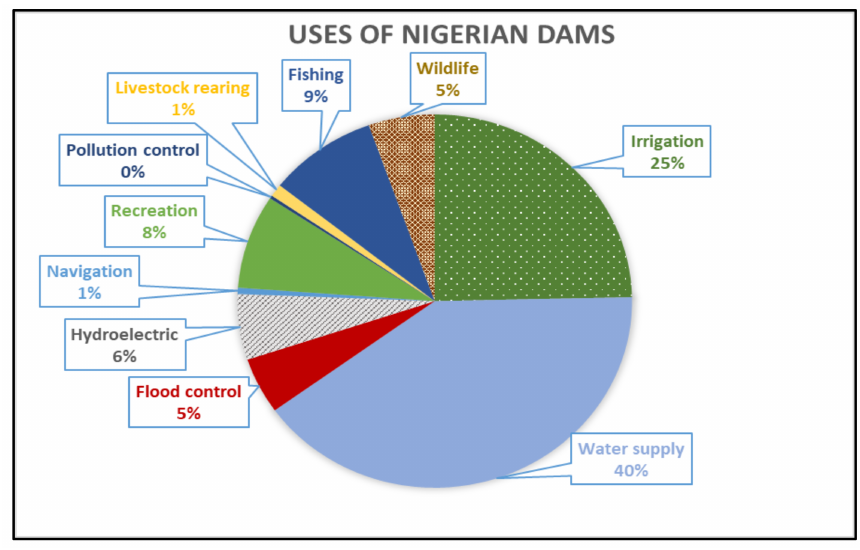
Figure 2. Uses of dams in Nigeria [63].